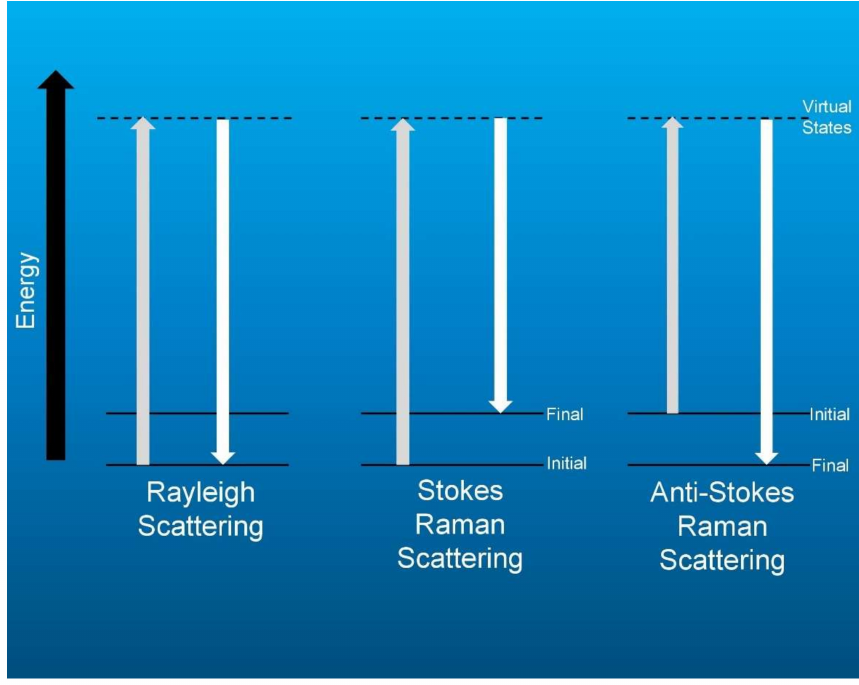
Figure 1. Energy level diagram of the Raman e ff